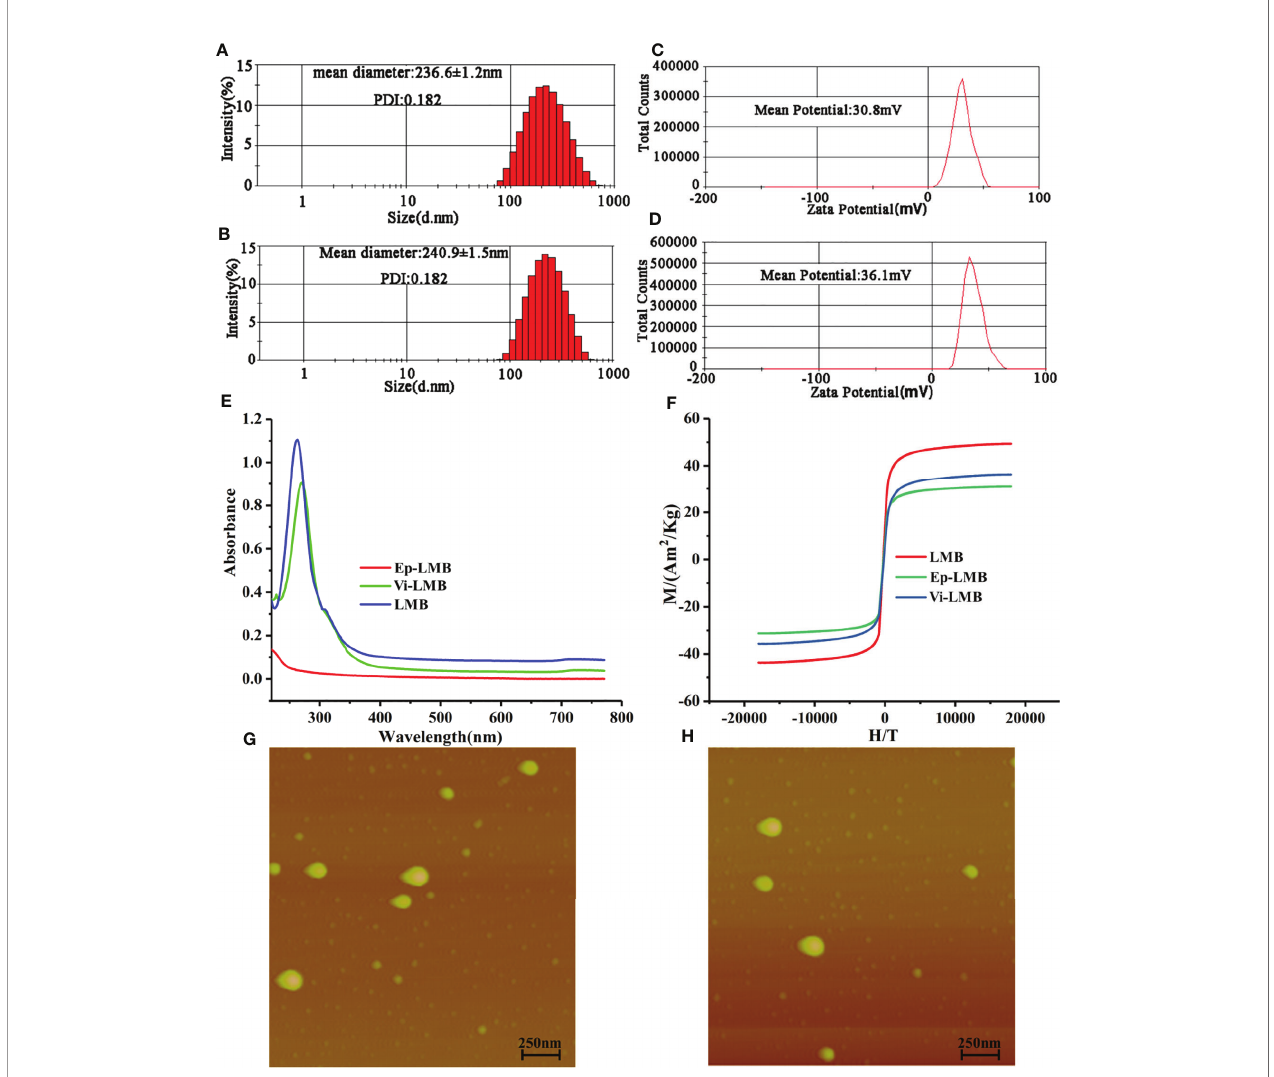
FIGURE 2 | Immunomagnetic bead characterization tests: (A) Particle size distribution of Ep-LMB; (B) Particle size distribution of Vi-LMB; (C) Potential test map of Ep -LMB; (D) Potential test map of Vi-LMB; (E) Ultraviolet scanning spectrum of Ep-LMB, Vi-LMB and LMB; (F) Hysteresis curve; (G) Atomic force test results of Ep- LMB; (H) Atomic force test results of